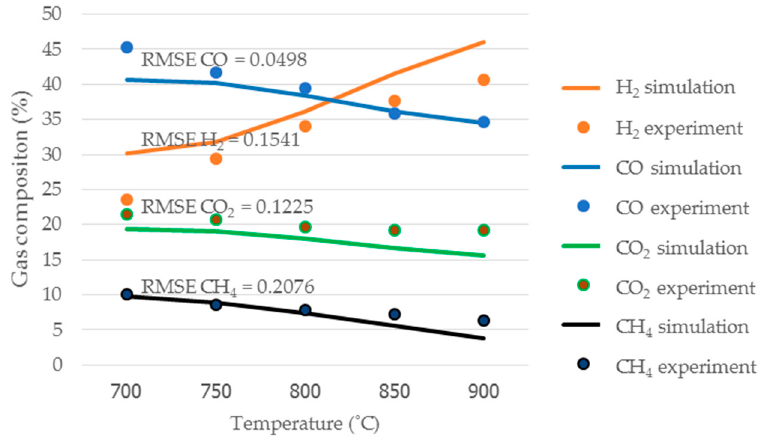
Figure 3. Experimental and simulation data comparison of gas composition with respect to gasification temperature.